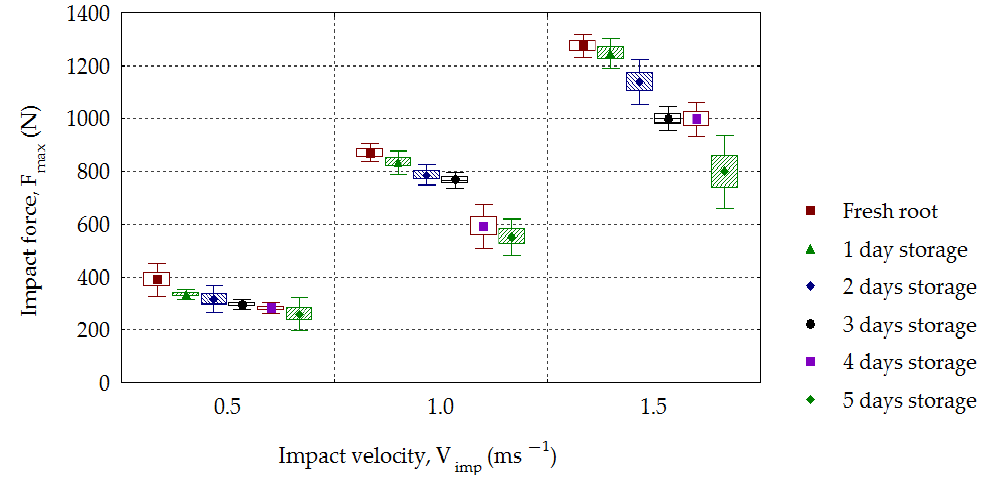
Figure 9. Diagram of maximal impact force ( F max ) dependence on impact velocity ( V imp ) for the stored beets.